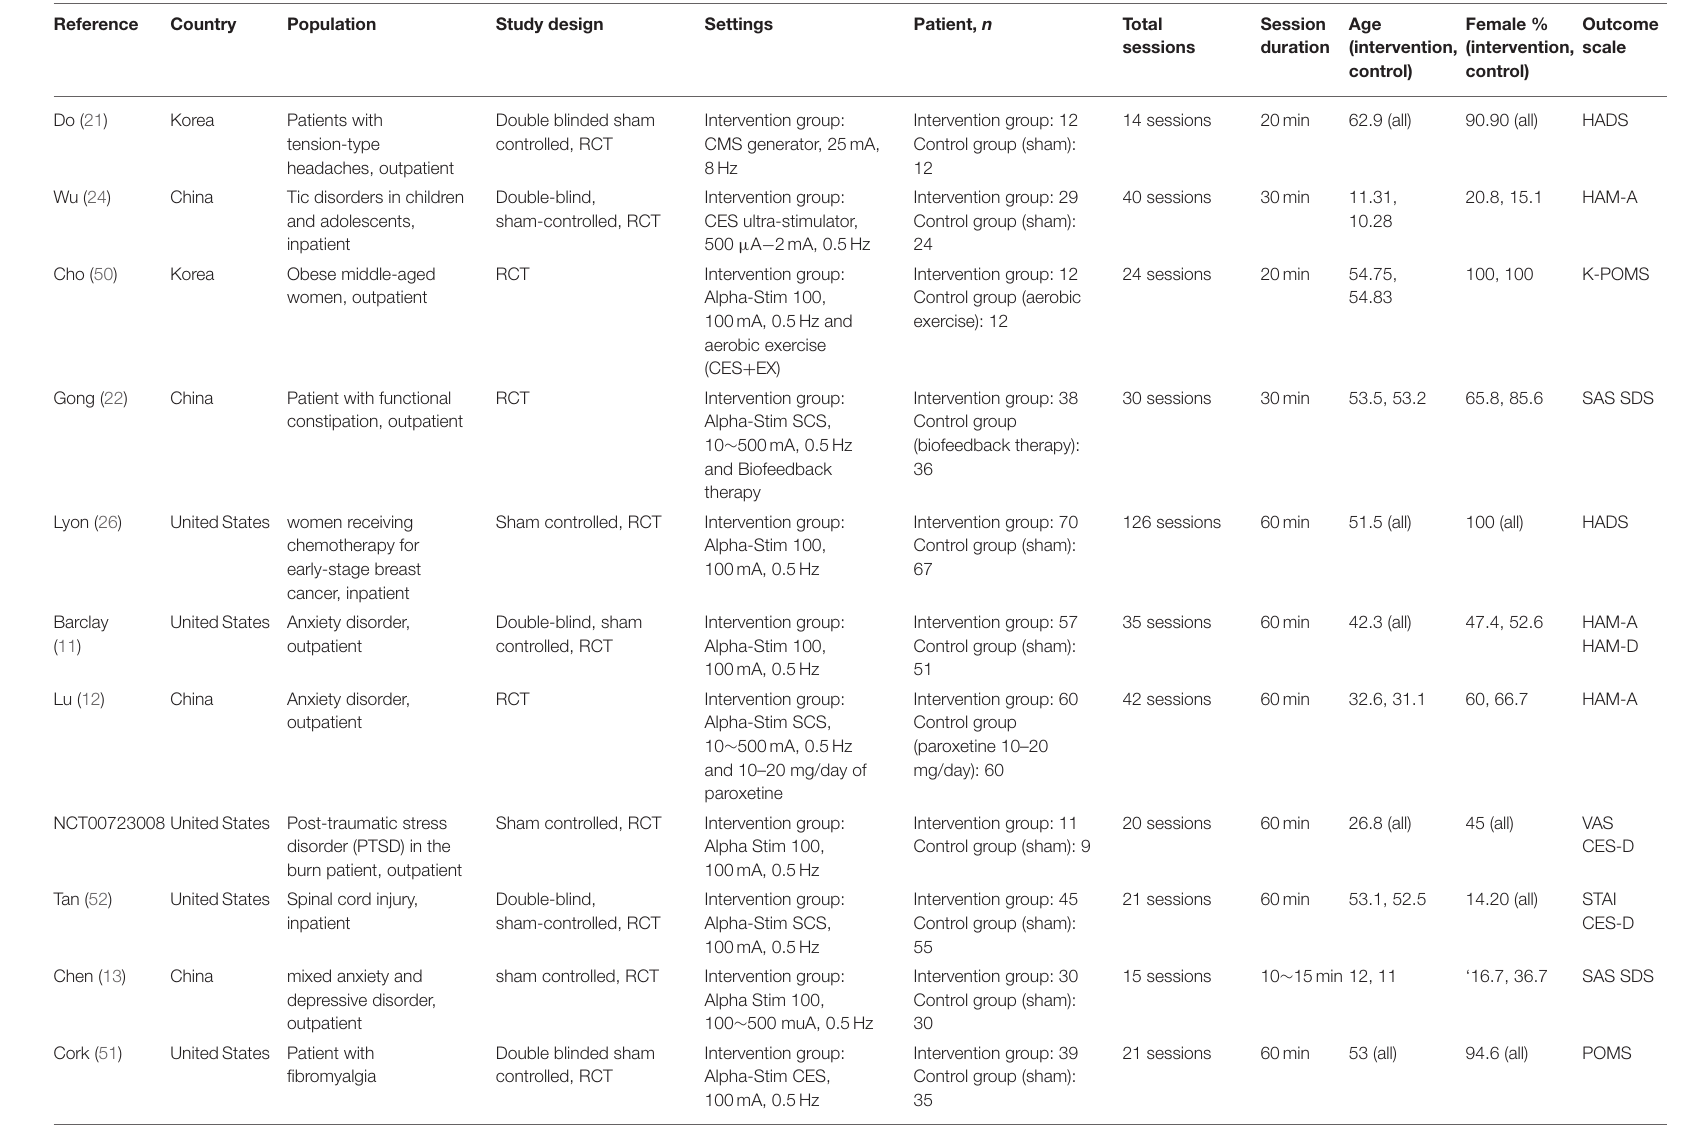
The characteristics and demographics of the included studies. RCT, randomized-controlled trial; HAM-A, Hamilton anxiety depression rating score; HAM-D, Hamilton depression rating score; K-POMS, Korean edition of profile of mood states; POMS, the profile of mood states; HADS, Hospital anxiety and depression scale; SAS, self-rating anxiety scale; SDS, self-rating depression scale; VAS, visual analog scale; CES-D, the center for epidemiologic studies depression scale; STAI, the state-trait anxiety